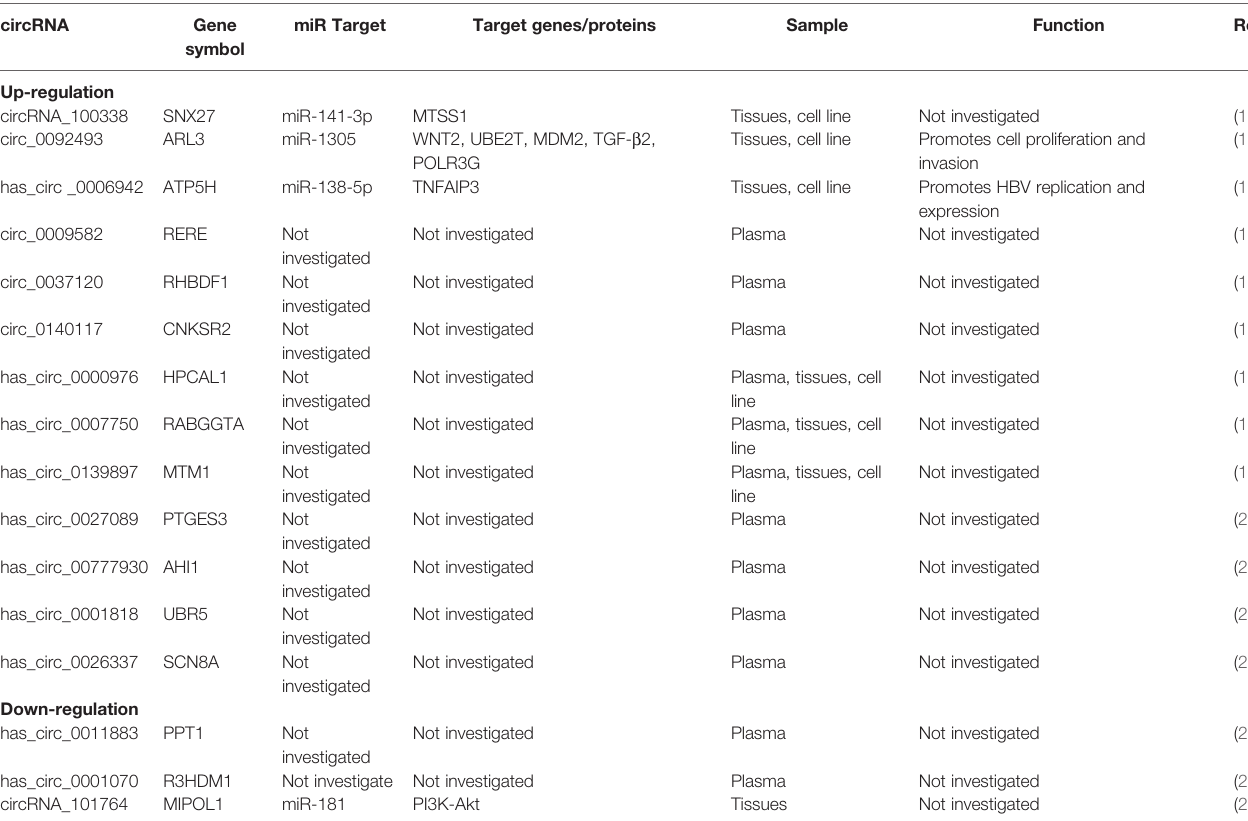
TABLE 1 | Overview of the identi fi ed circular RNA in HBV associated hepatocellular carcinoma. circRNA Gene miR Target Target genes/proteins Sample Function symbol